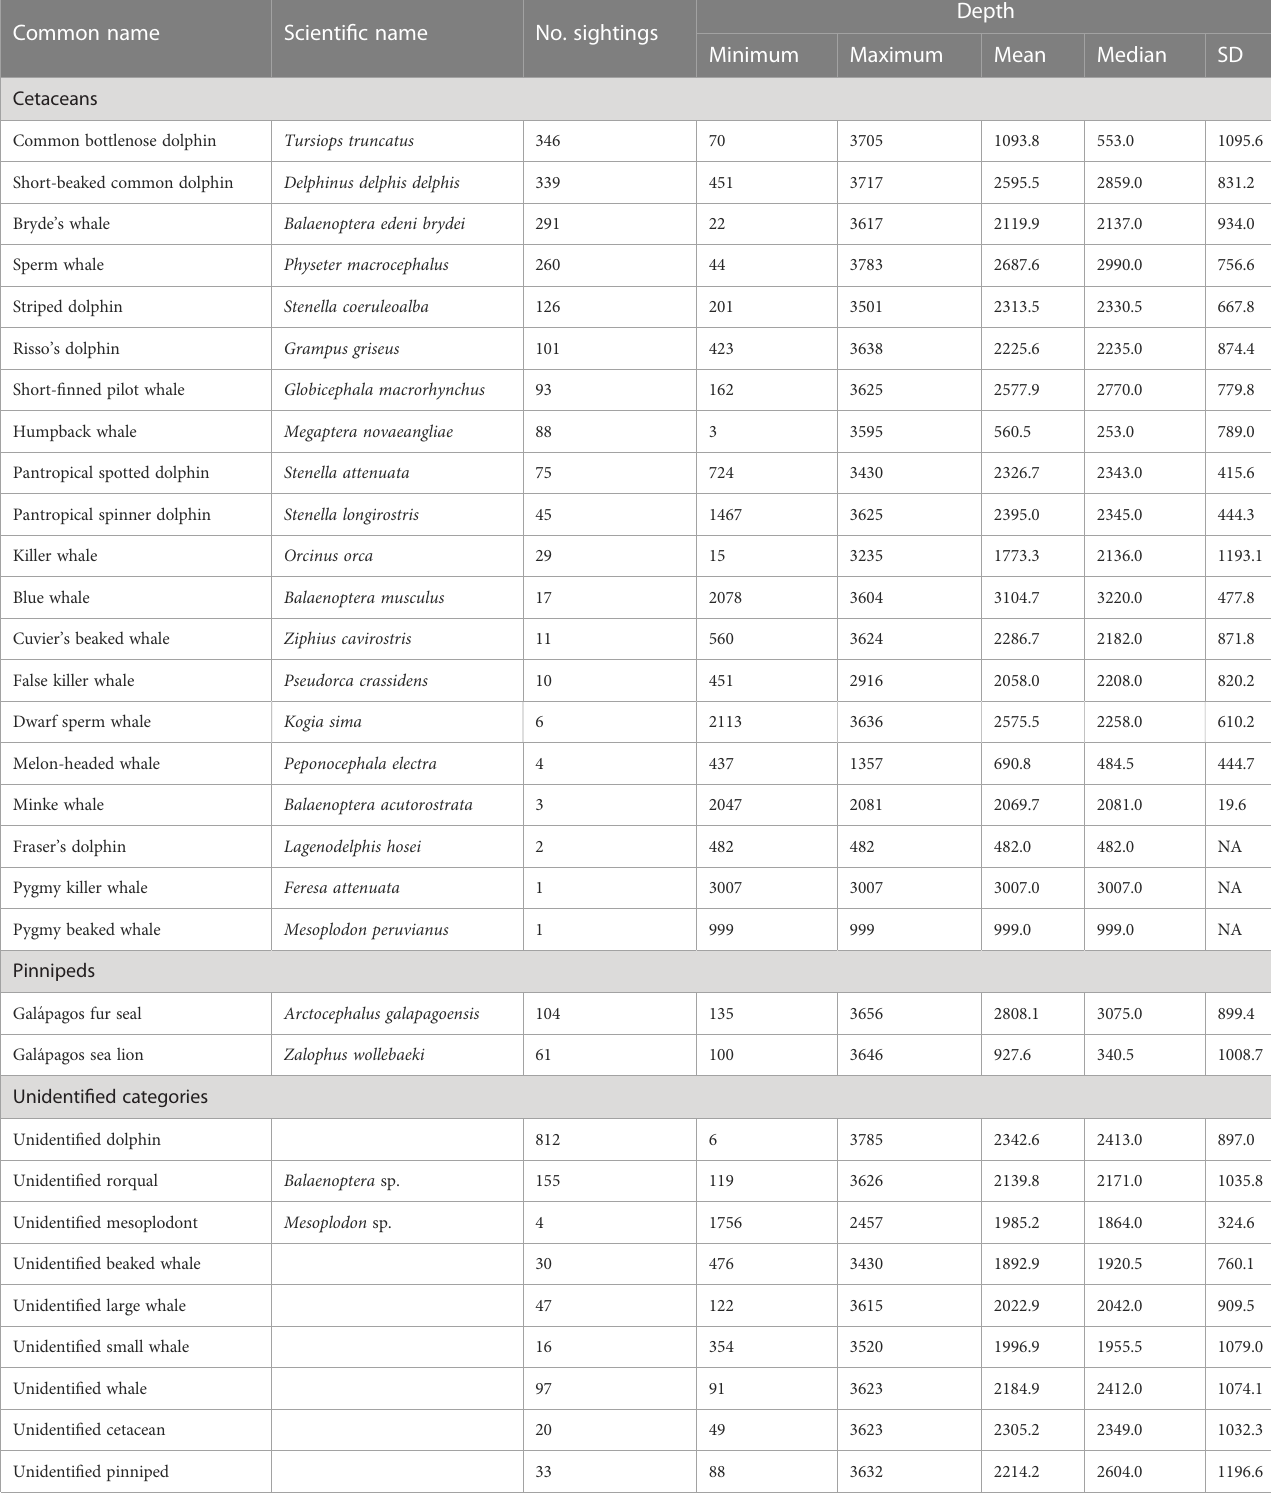
TABLE 1 Cetacean species reported in Gala ́ pagos, listed in decreasing frequency, based on a comprehensive compilation of marine mammal sightings (n = 3,227) in an area de fi ned by a 4×4-degree box bounded by 88.5-92.5°W and 2°S-2°N, spanning the period 1973-2014 (see text for details and Figures 2 and 3 for graphical